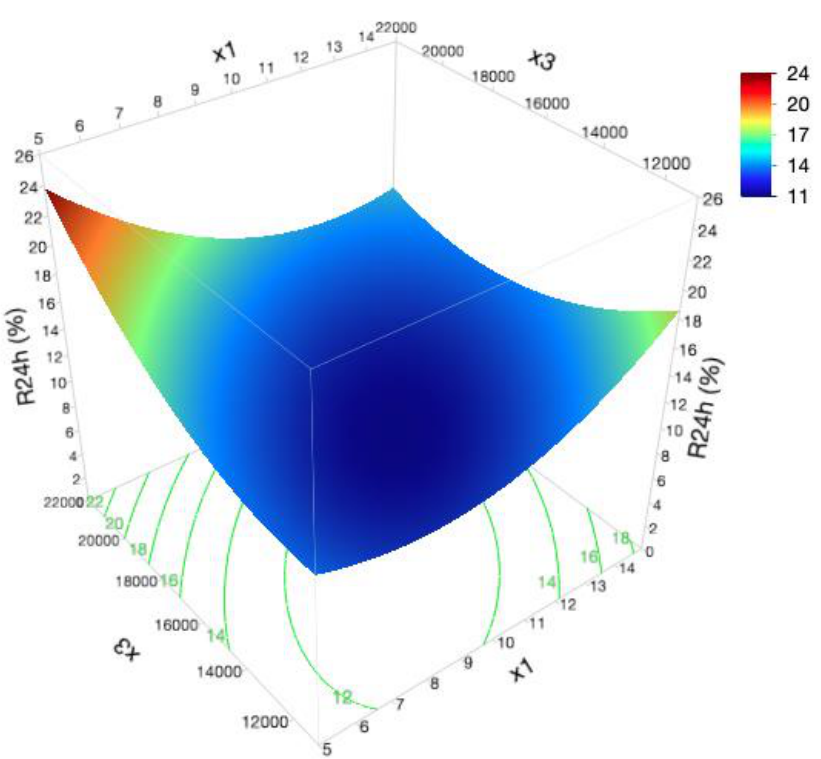
Figure5. Responsesurfaceplotshowingthee ff ectofglycerolmonostearateamountandhomogenization Figure 5. Response surface plot showing the effect of glycerol monostearate amount and rate interaction on R 24h homogenization rate interaction on R 24h response.